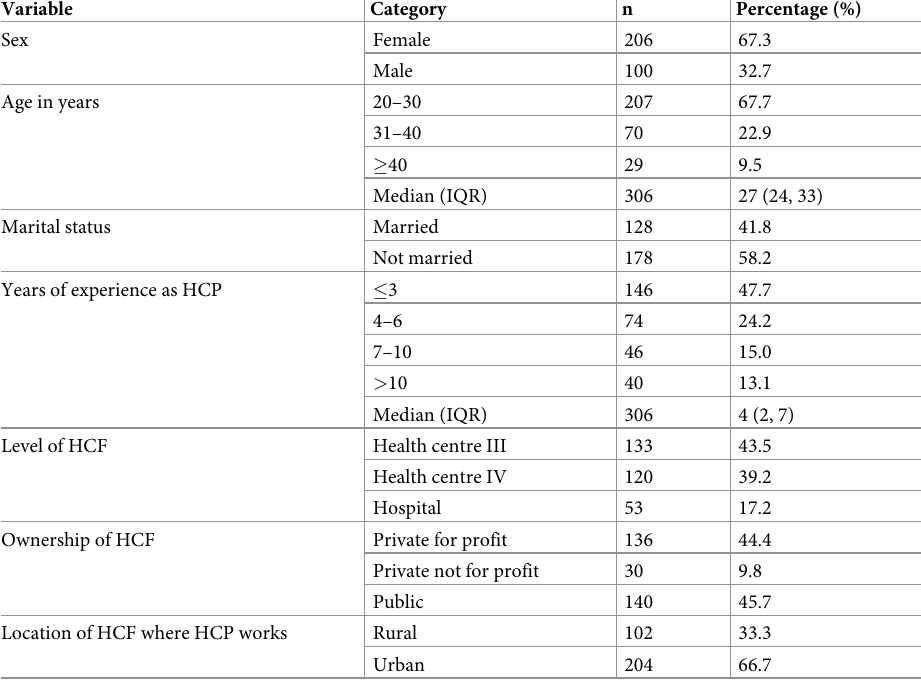
Table 2. Socio-demographic characteristics of